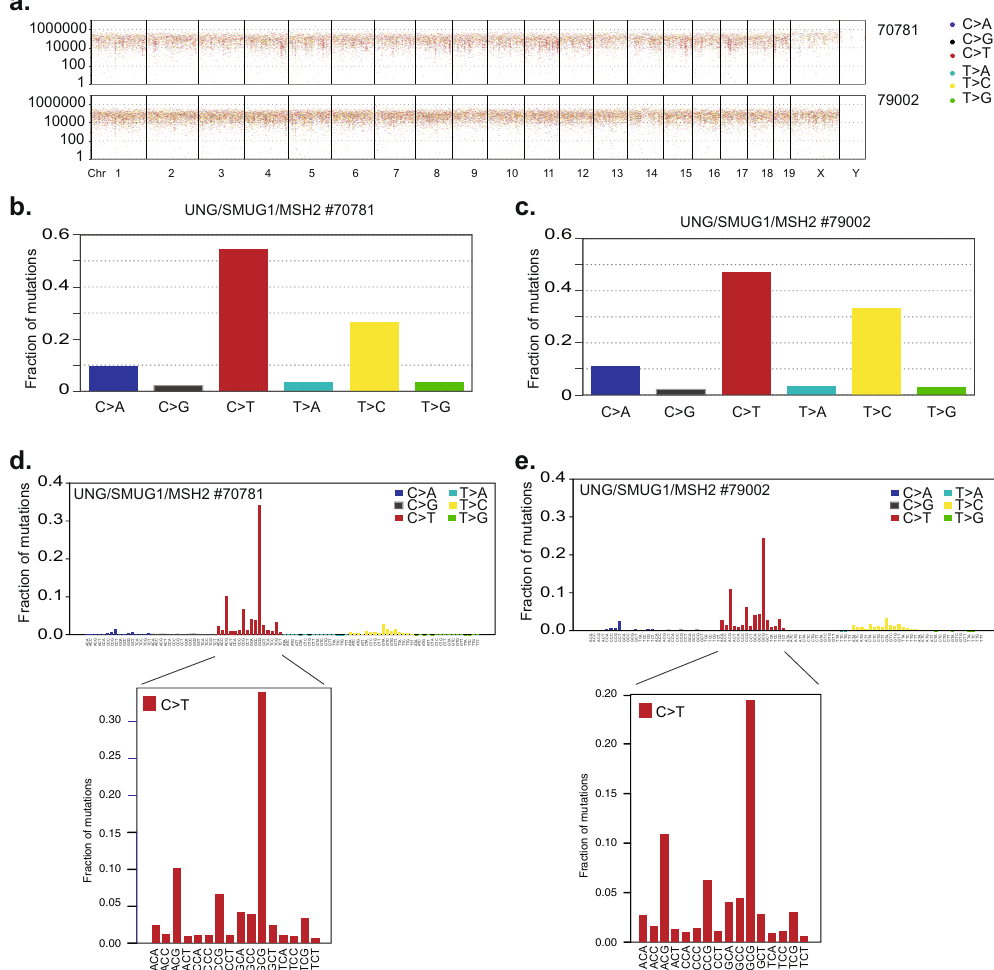
Figure 4. Mutational landscape of UNG/SMUG1/MSH2 triple knockout tumour. Whole genome sequencing was performed to assess the mutational profiles in tumour arising spontaneously in UNG/SMUG1/MSH2 triple knockout mice. ( a ) Rainfall plots showing the distribution of mutations in tumours from two different mice (denoted 70781 or 79002) along each chromosome. ( b , c ) The types of base pair changes represented as the fraction of the total variant observed. ( d , e ) Trinucleotide plots summarising the sequences surrounding each variant normalised to genomic trinucleotide occurrence. The sequence context of all mutations occurring at C:G base pairs is magnified